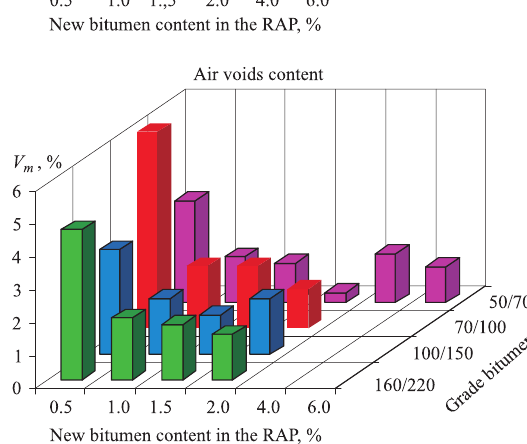
Fig. 6. Impact of various grade rejuvenating bitumen amount in RAP mixture on the physical and mechanical properties of Marshall